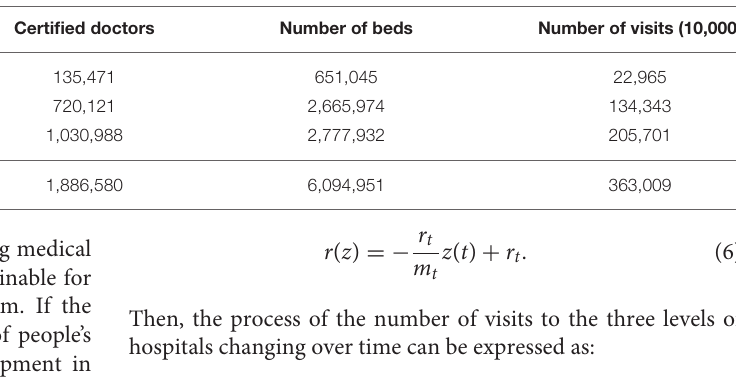
TABLE 1 | The medical resources and services of Chinese hospitals in 2019